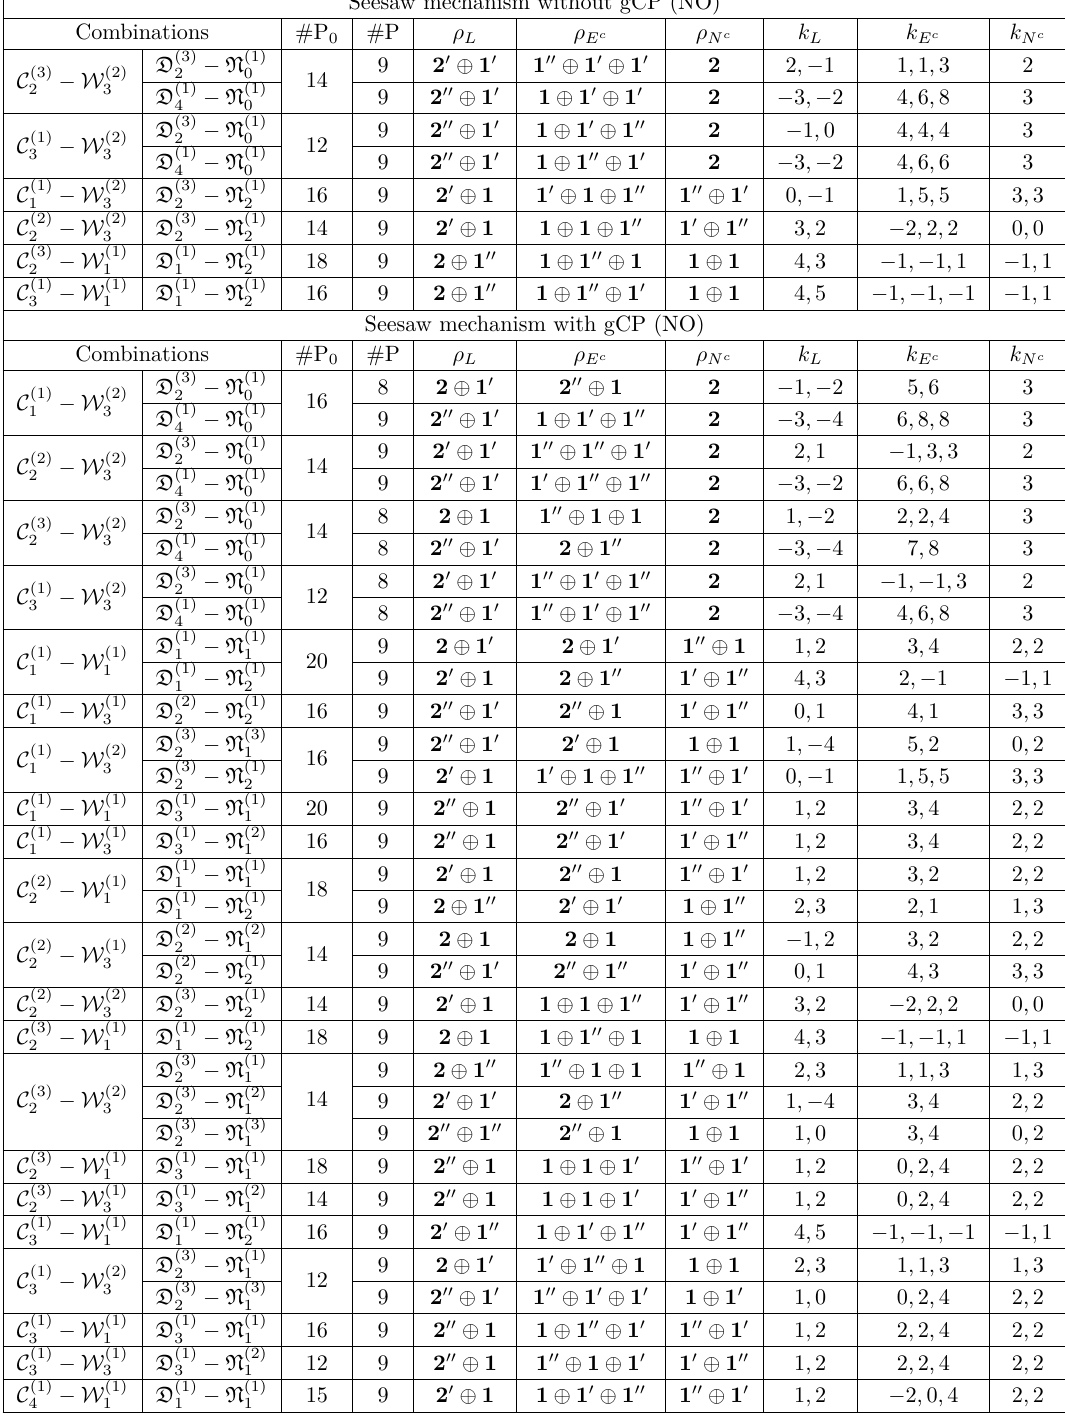
Table 22. Representative models for the viable patterns of texture zero in ( M E , M ν ) that can accommodate the experimental data at 3 σ level for NO neutrino mass spectrum. Here, neutrinos are Majorana particles and their masses are assumed to be generated by the type-I seesaw mechanism. The models are given without and with gCP. The same convention as table 14 is